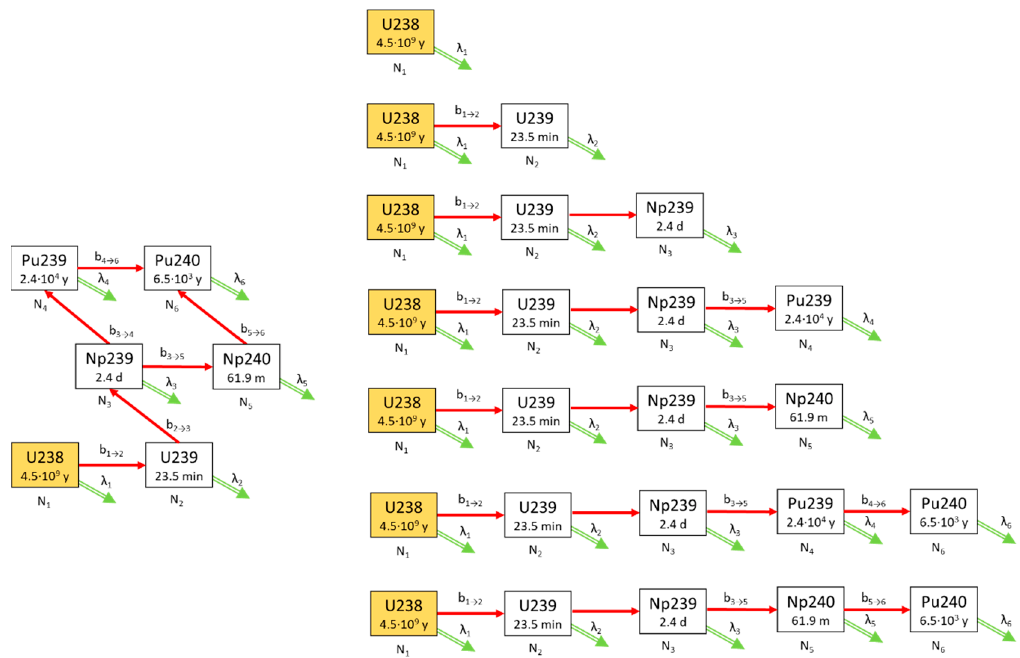
Figure 1. Decomposition of a sample transformation map of decay and transmutation reactions (left) to linear chains (right).